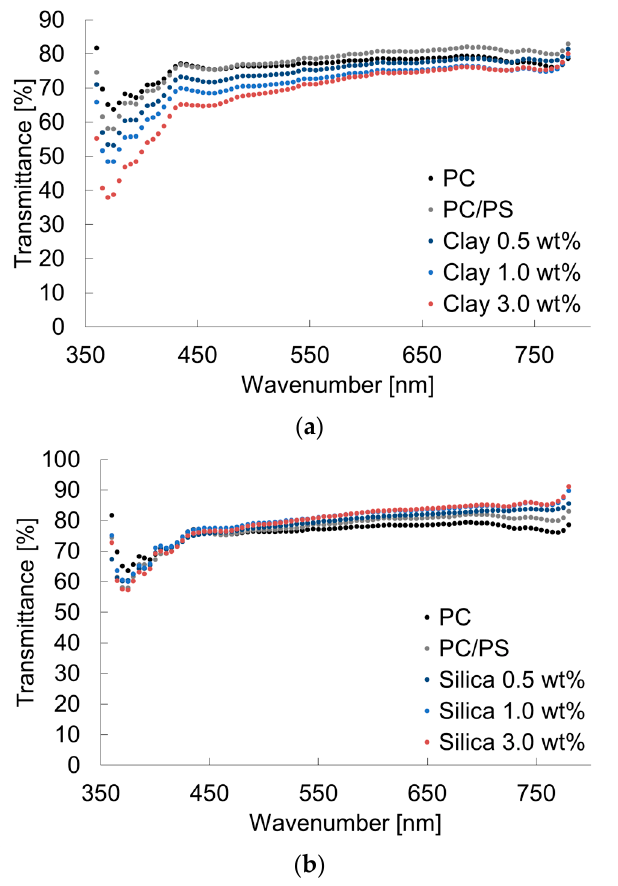
Figure 5. Transmittances of PC/PS/nano-filler composites: ( a ) PC/PS/clay; ( b ) PC/PS/silica.